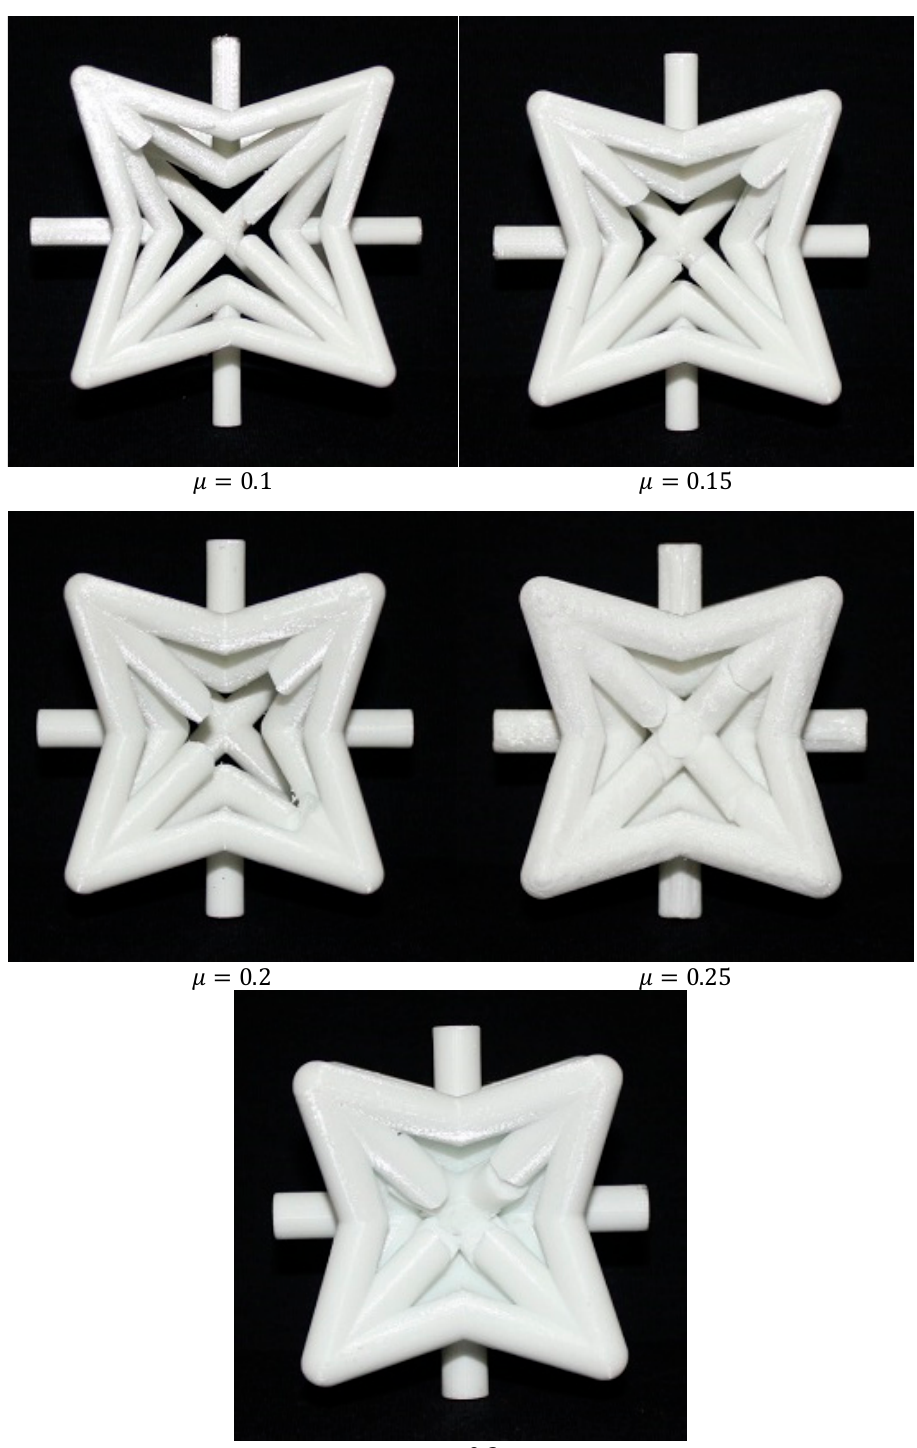
Figure 10. Top view of specimens with different relative densities after the final fracture. Table 2. Elastic mechanical properties of cylindrical specimens made from poly-lactic acid (PLA) filaments.